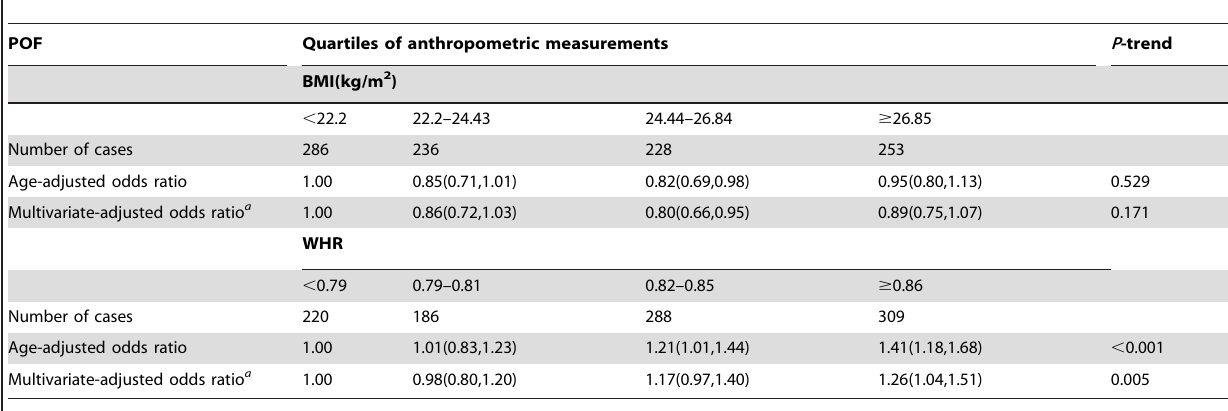
Table 2. Adjusted ORs and 95%CIs for POF in the Shanghai Women’s Health Study by anthropometric measurement quartiles.